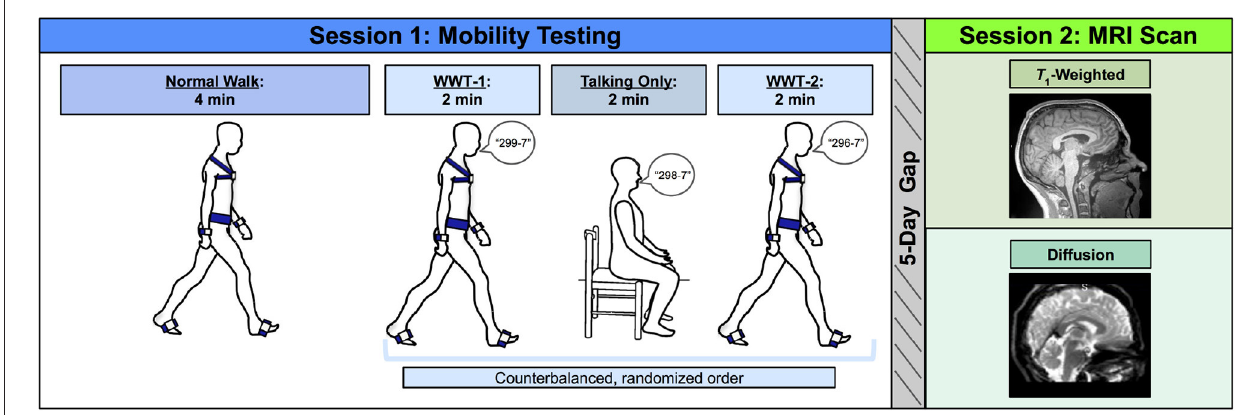
FIGURE 1 | Methods overview. Left: During Session 1, participants first completed a normal (single task) overground walk (NW) at a comfortable self-selected speed. Next, participants completed three trials in a counterbalanced order: two walking while talking trials (WWT-1 and WWT-2) in which participants counted backwards by 7s while walking, and one talking only trial in which participants stayed seated while counting backwards by 7s. Right: Approximately 5 days later, during Session 2, participants completed an MRI protocol, which included a T 1 -weighted anatomical scan and a diffusion-weighted